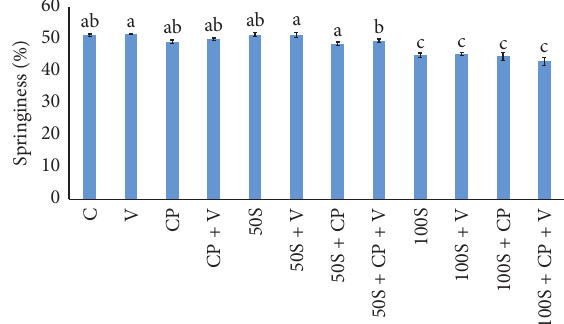
Figure 5: Springiness values for muffins made from two levels of stevianna as sugar replacer with or without cocoa powder and vanilla. Control (C); vanilla (V); cocoa powder (CP); cocoa + vanilla (CP + V); 50% stevianna (50S); 50% stevianna + vanilla (50S + V); 50% stevianna + cocoa (50S + CP); 50% stevianna + cocoa + vanilla (50S + CP + V); 100% stevianna (100S); 100% stevianna + vanilla (100S + V); 100% stevianna + cocoa (100S + CP); 100% stevianna + cocoa + vanilla (100S + CP +